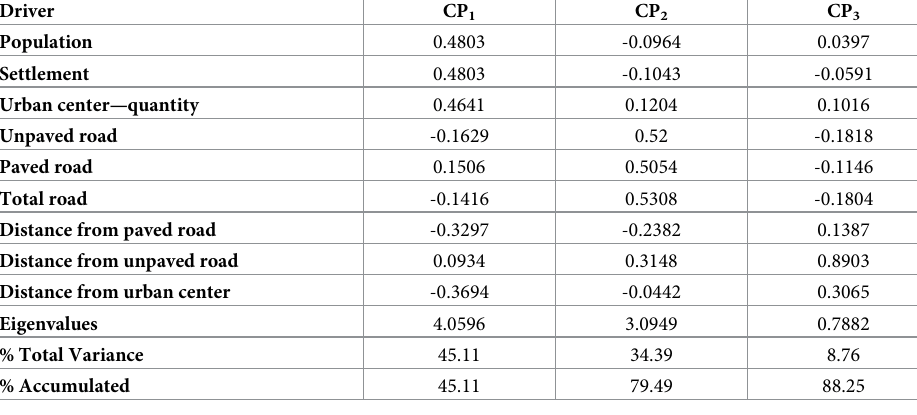
Table 2. Results of the principal components analysis (PCA) of the anthropogenic